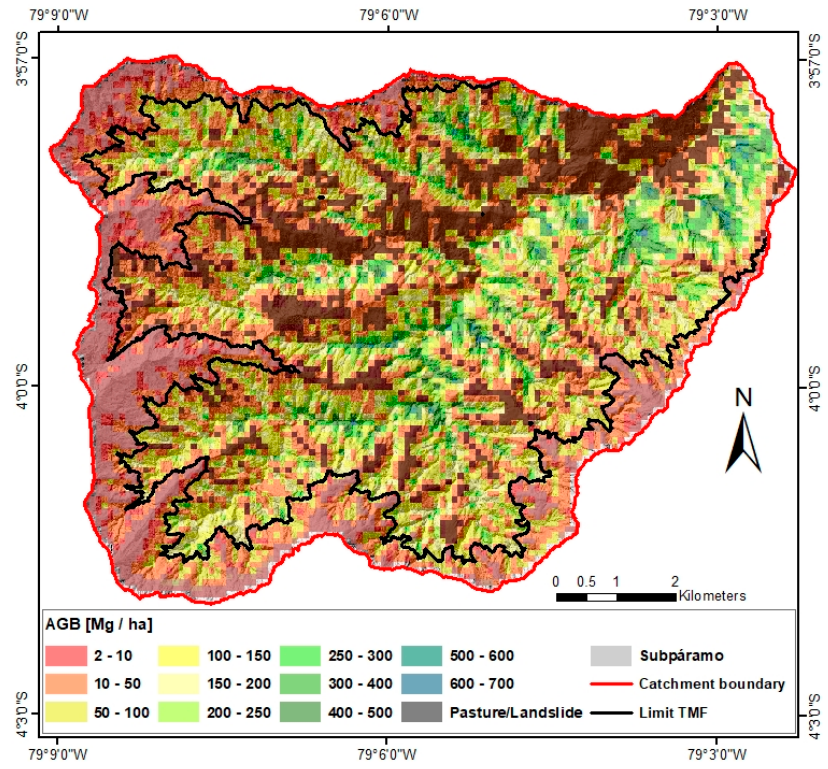
Figure 12. Spatial distribution of AGB in the Rio San Francisco catchment.